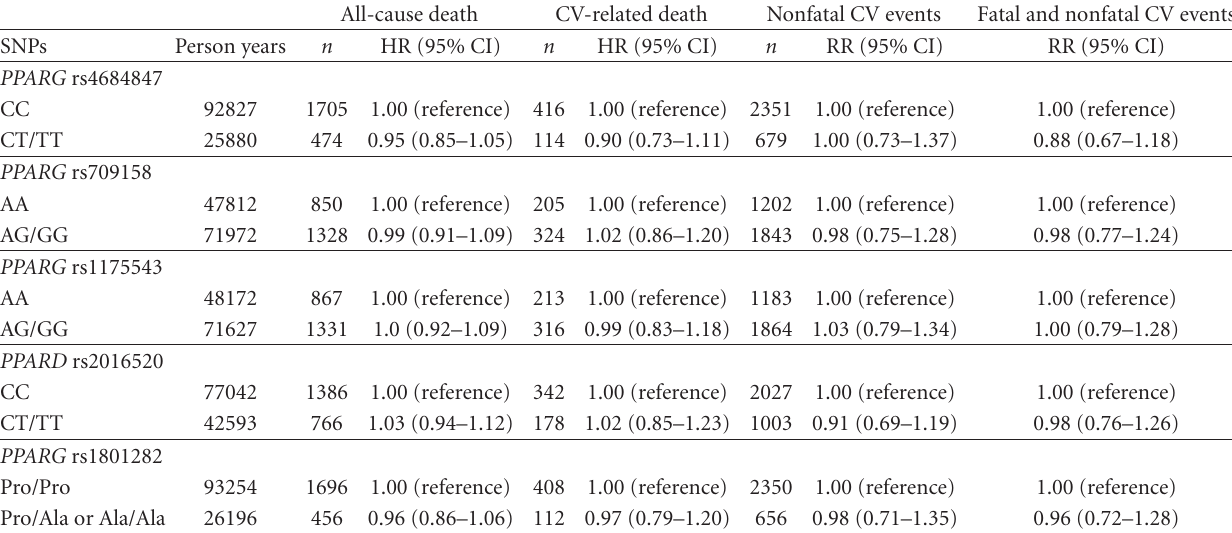
Table 3: Age-adjusted hazard ratios (HR) and 95% confidence intervals (95% CI) of all-cause and cardiovascular mortality and nonfatal cardiovascular events for 5 PPAR polymorphisms. Person years: cumulative person years of follow up. RR (95% CI): relative risk using poisson regression.